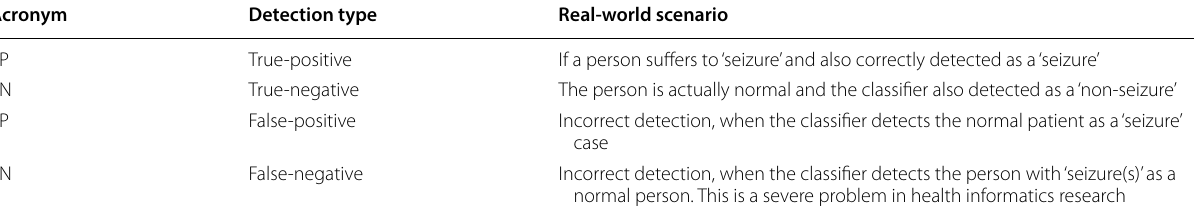
This table describes each parameter metric considering seizure and non-seizure case